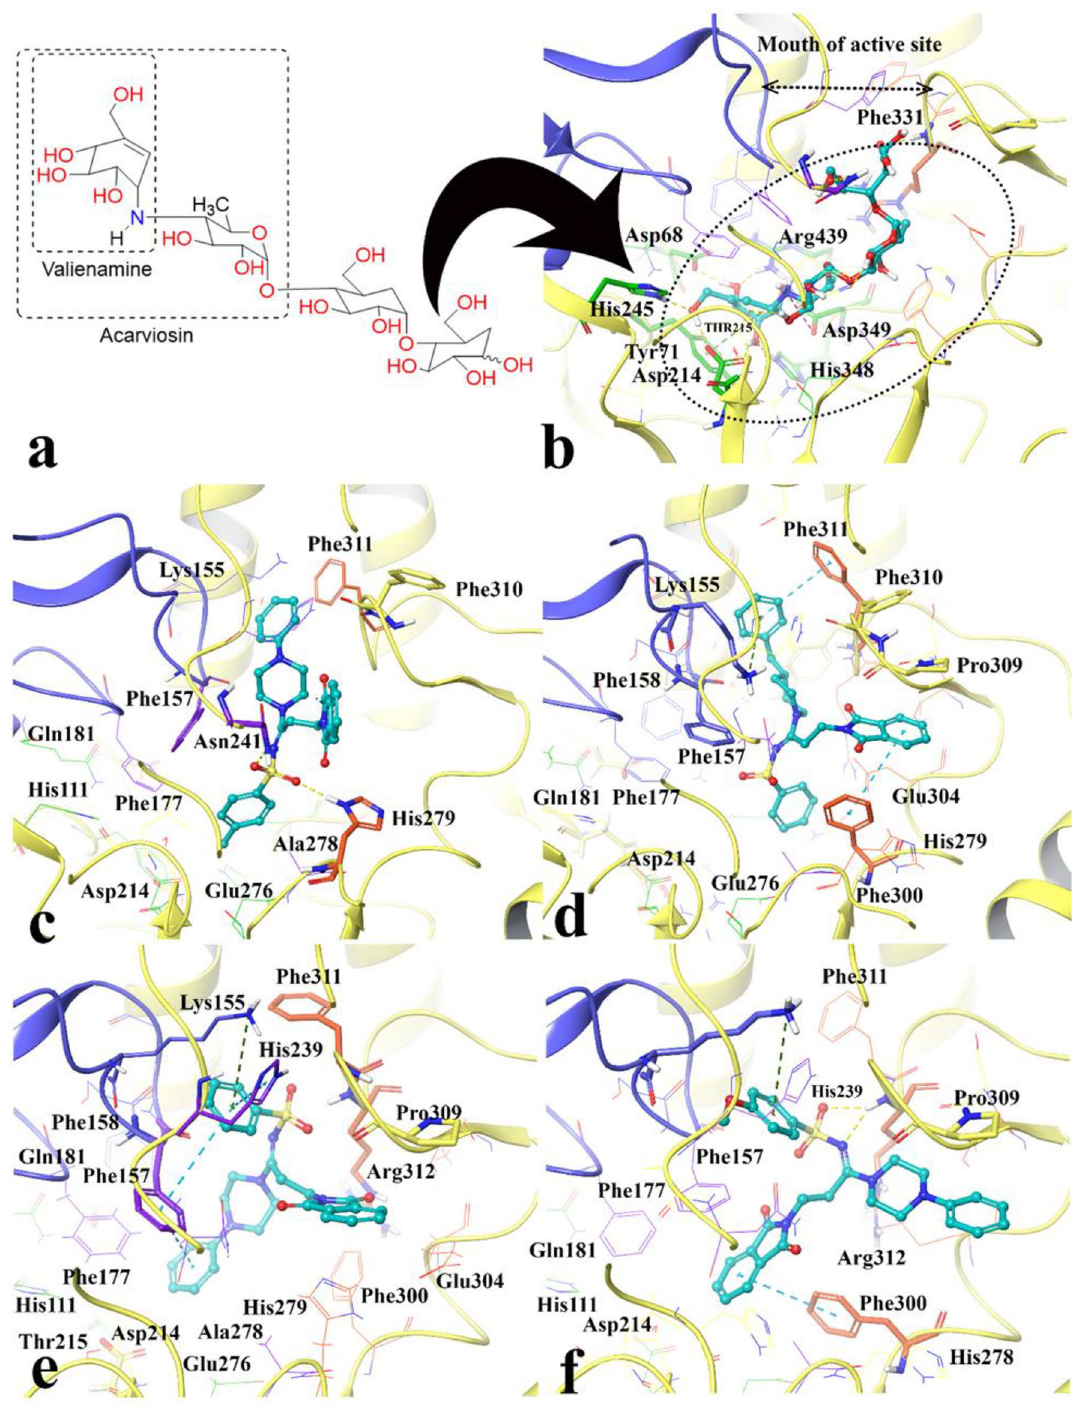
Figure 7. Acarbose structure ( a ) and docked representation of acarbose ( b ), the most active synthesized compounds 4m ( c ) and 4i ( d ) and the lowest active compounds 4l ( e ) and 4n ( f ) over the α-glucosidase active site. Domain A and B are colored in yellow and blue, respectively. The docked compounds colored in cyan. The α-glucosidase subsides residues include region − 1 and + 1 are in green color also the + 2 and + 3 subsides are in purple and orange, respectively (Maestro Molecular Modeling platform (version